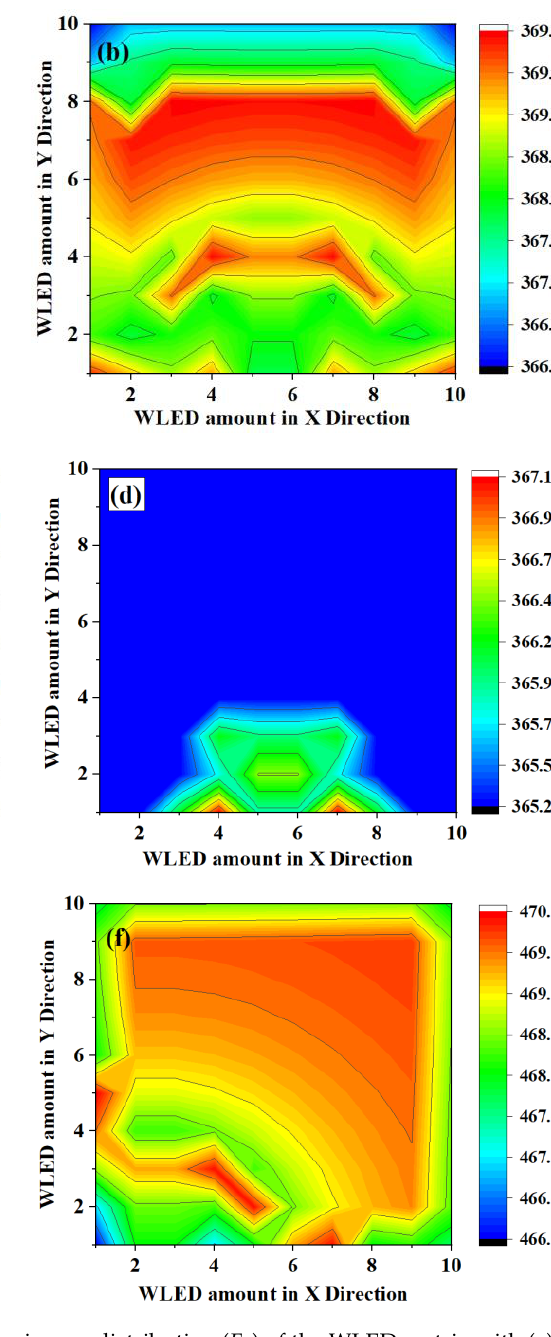
Figure 8. Optimized spatial illuminance distribution ( E o ) of the WLED matrix with ( a ) distance of 2 m between neighboring WLEDs; ( b ) distance of 3 m between neighboring WLEDs; ( c ) distance of 5 m between neighboring WLEDs; ( d ) distance of 10 m between neighboring WLEDs; ( e ) 2 m movement of the window position (distances of WLEDs are set as 2 m); ( f ) 6 m movement of the window position (distances of WLEDs are set as 2 m). Dimension of the WLED matrix equals 10 ×